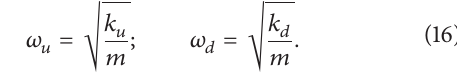
in which 𝑘 𝑢 and 𝑘 𝑑 are the stiffness of undamaged and damaged system, respectively. The initial velocity and dis- placement due to the impulse excitation are assumed to be 0 and V 0 , respectively. The circular frequency of the